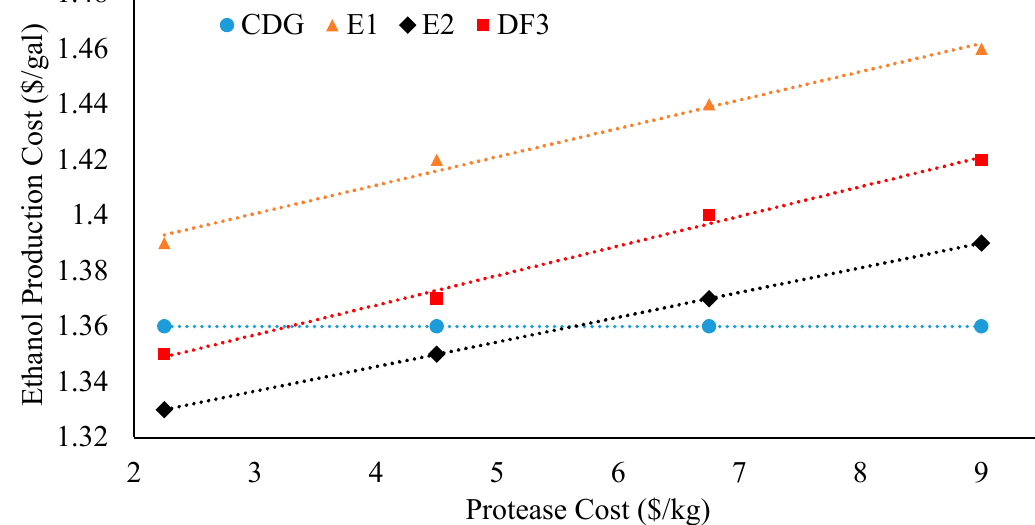
Figure 5. Effect of protease purchase cost on ethanol production price in CDG, E1, E2 and DF3 processes.